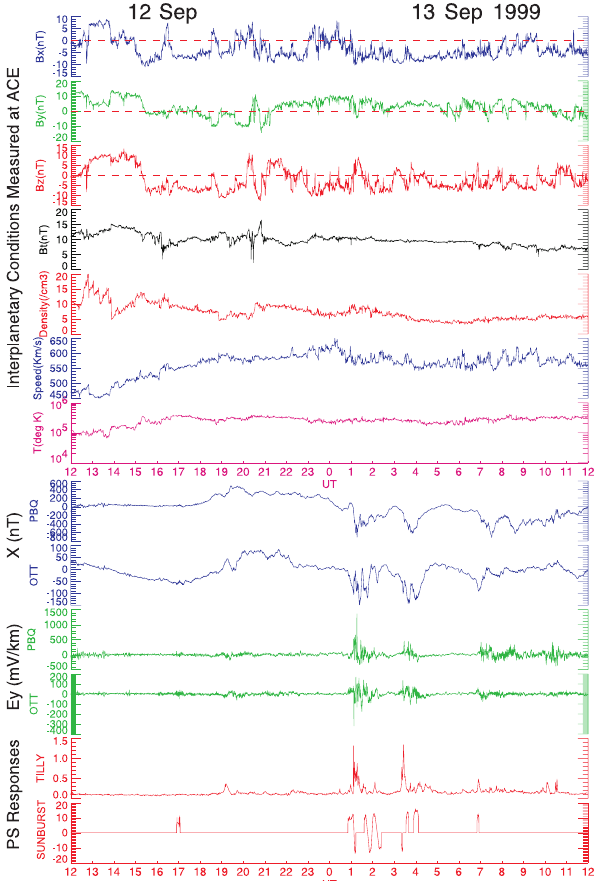
Fig. 4. A stack plot of ACE solar wind data (upper panel) and ground data (lower panel) for 12–13 September 1999. The upper panel shows the three components of the interplanetary magnetic field in GSM (Geocentric Solar Magnetospheric) coordinate system ( B x , B y , and B z ), total interplanetary field strength ( B t ), proton density, solar wind speed and temperature. The lower panel shows the northward component of the geomagnetic field ( x ) as recorded at the GSC’s magnetic observatories located in PBQ and OTT, and the eastward component of the electric field ( E y ) as calculated from x . “PS Responses” stands for Power System Responses and refers to the AC harmonics in percentage measured by Hydro Qu´ebec at the substation Tilly, and the geomagnetically induced current (GIC) in Amperes recorded at the Sunburst